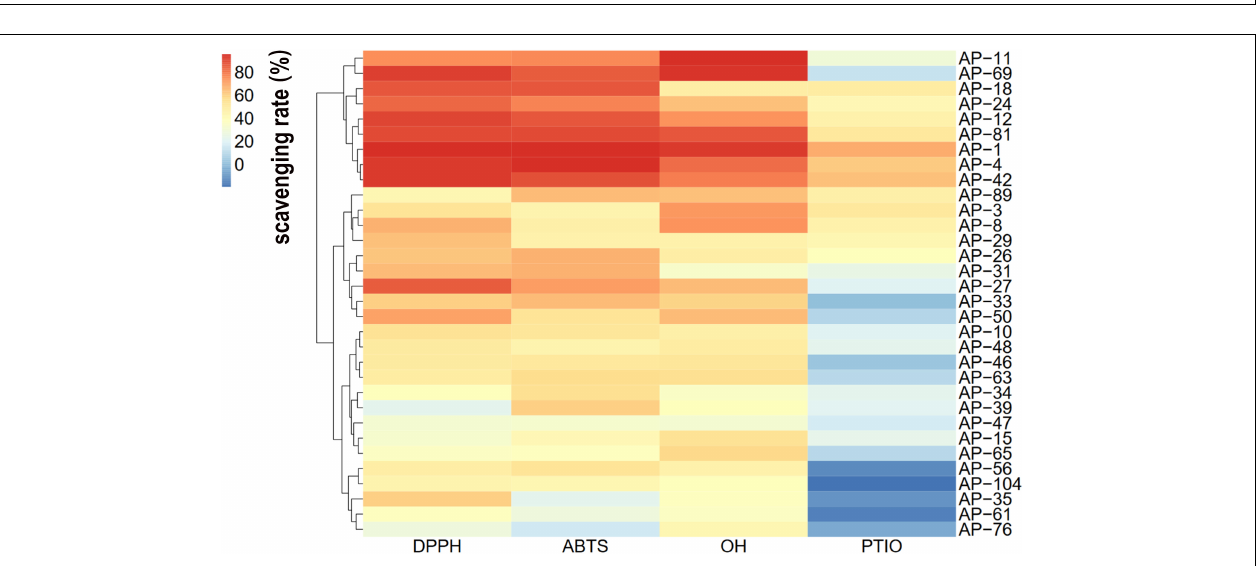
FIGURE 3 | Hierarchical cluster analysis (HCA) of the antioxidant activity of extracellular extracts (EXEs) was obtained from 32 fungal endophytes.